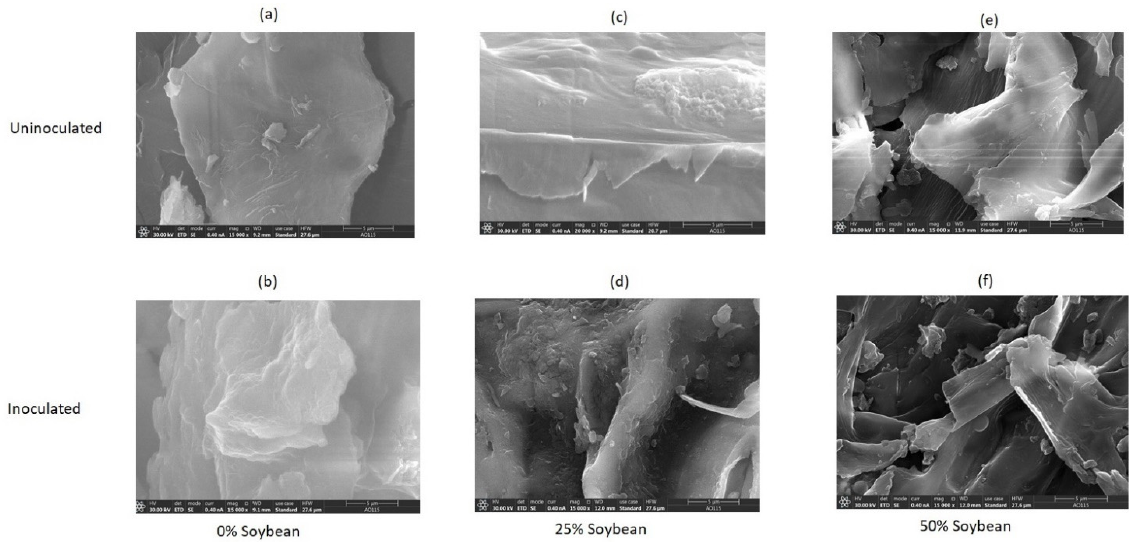
Figure 4. ( a – f ): SEM images showing the influence of soybean inclusion and L. plantarum A1 inocu- lation on surface morphology of sorghum silage. inoculation on surface morphology of sorghum silage.